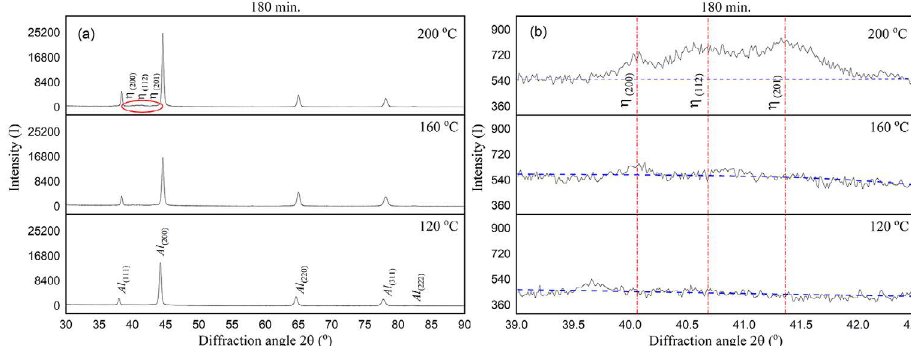
Figure 5. XRD results from samples aged for 180 minutes at different aging temperatures, a) Peaks obtained between 30- 90º scanning angles from specimens aged for 180 minutes, b) Zoomed image (39- 42.5 scanning